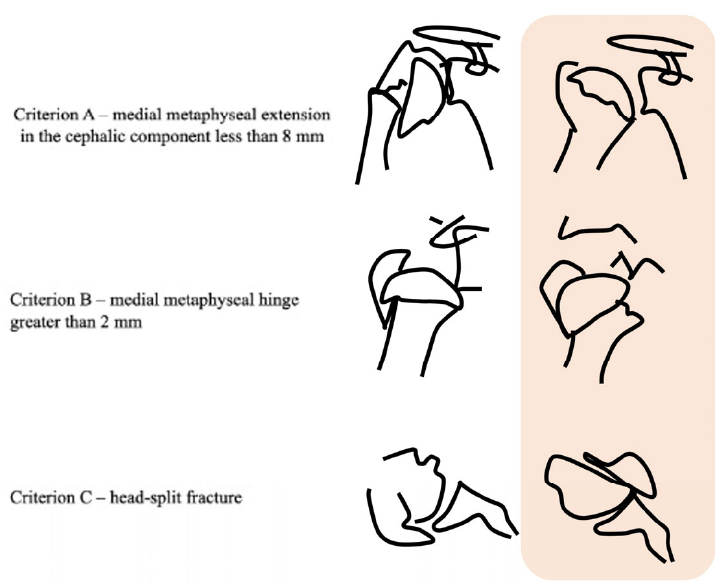
Figure 1. The three Hertel criteria adopted in the study. Criterion A represents the medial metaphyseal extension < 8 mm; Criterion B represents the medial metaphyseal hinge < 2 mm; and Criterion C represents the humerus head ‐ split fracture. (Image produced on computer and from the author’s personal archive VG).